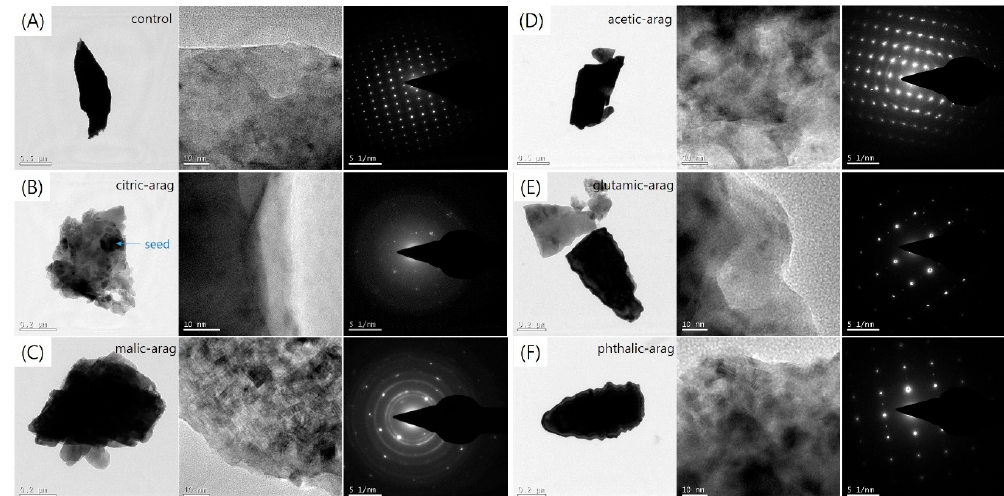
Figure 5. TEM images (left) and selected area electron diffraction (SAED) patterns (right: derived from the middle images, which are the magnified left TEM images) for the co-precipitated aragonite samples. ( A ) Control, ( B ) citric-arag, ( C ) malic-arag, ( D ) acetic-arag, ( E ) glutamic-arag, and ( F ) phthalic-arag.